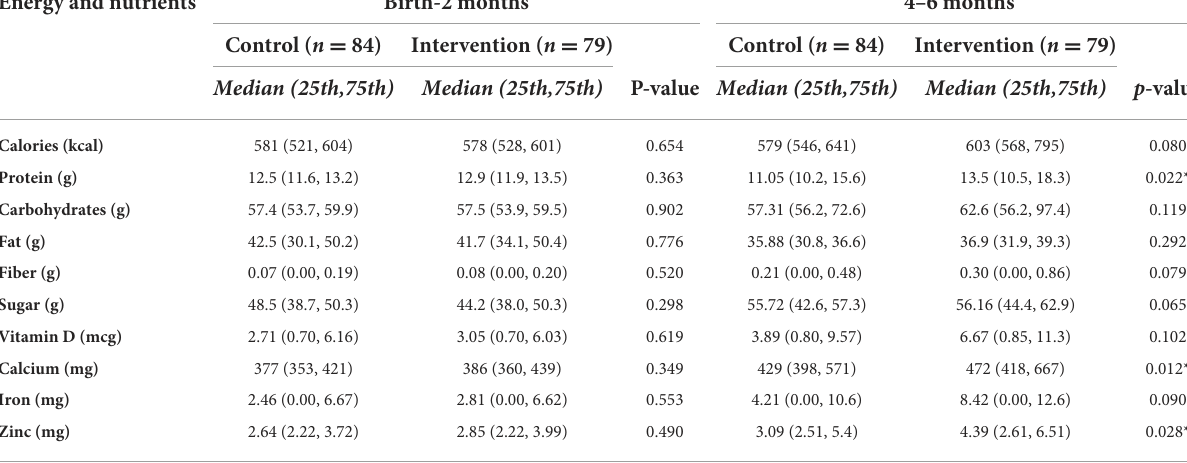
TABLE 2 Energy and nutrients intake at baseline (0–2 months) and at the follow-up visit (4–6 months).